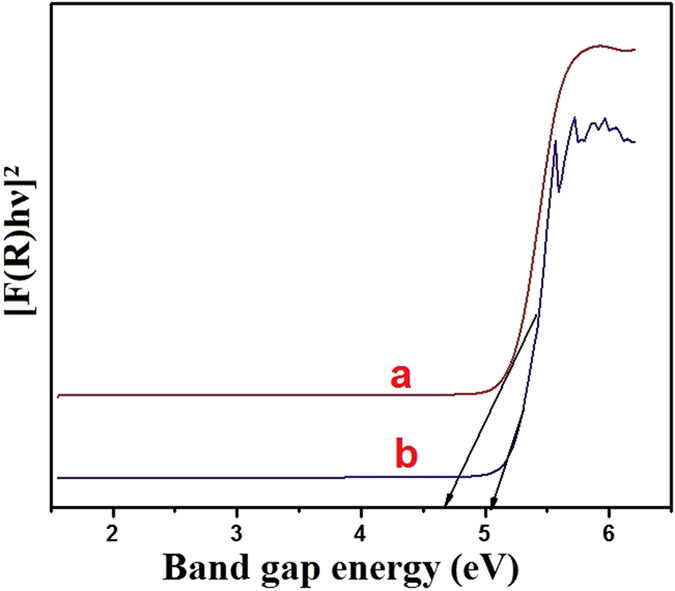
Diffuse reflectance spectra of (a) CeO2 NPs prepared by the MCM method and (b) CeO2 NPs sample prepared by the CRSGM.